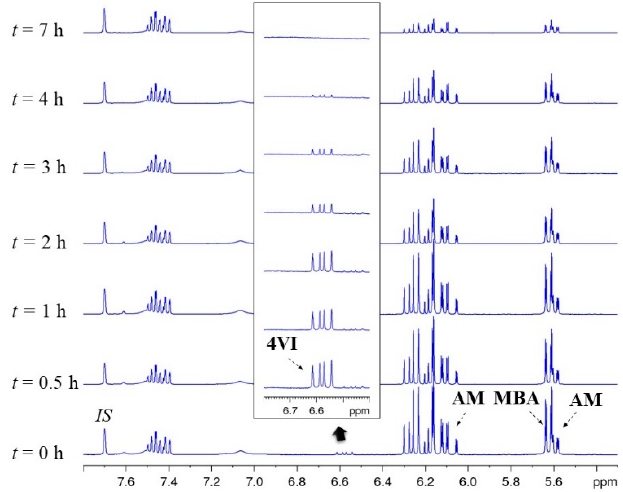
Figure 6. Stacked plot of a selection of the 1 H NMR (400 MHz, 298 K, DMSO- d 6 ) spectra recorded at different reaction times during the kinetic study of polymerization N44 (C M = 1%, AIBN = 5%, 70 °C). Peaks monitored for each monomer and the internal standard (2-ethylnaphtalene) are indicated. Inset: zoomed-in region for the 4VI signal being monitored.